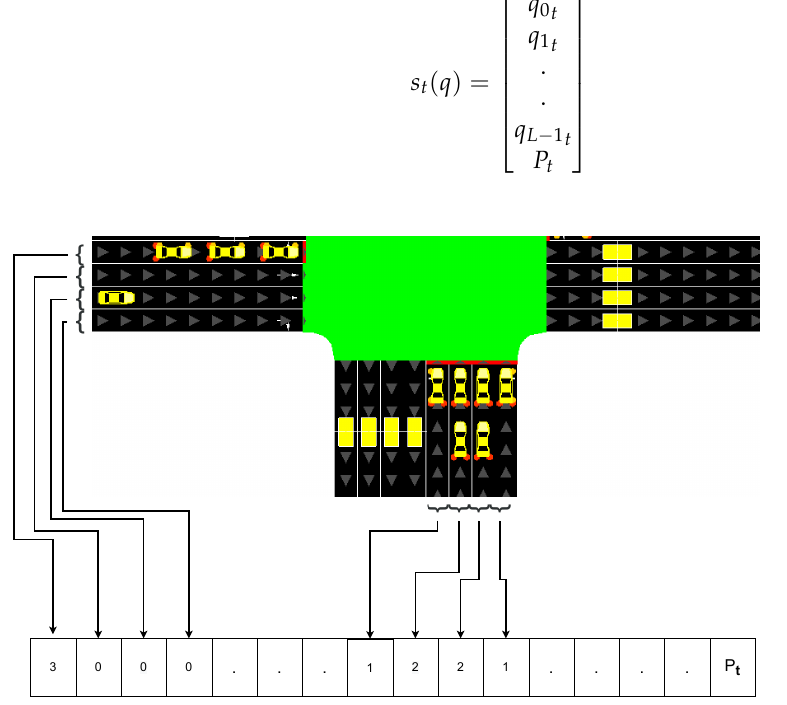
Figure 3. Example of the state vector extracted from the intersection